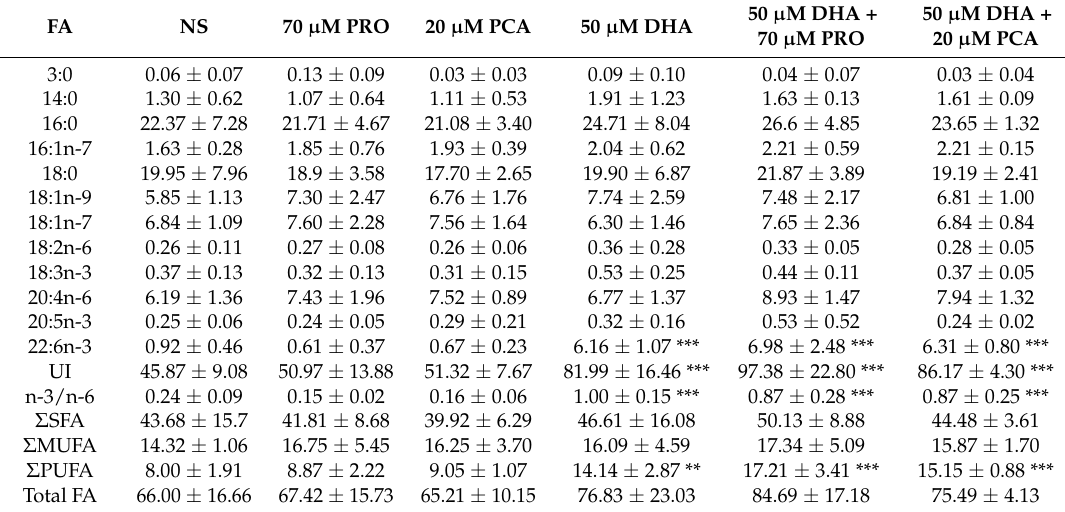
Table 2. Fatty acid content of not supplemented (NS) and supplemented cells after 6 h supplementation. Data were obtained by gas chromatography (GC) analysis, and are expressed as µ g FA/10 6 cells. Data in each group are means ± standard deviation (SD) of five samples derived from three independent experiments. Statistical analysis was conducted with the one-way ANOVA (22:6n-3 p < 0.001; UI p < 0.001; n-3/n-6 p < 0.001; Σ PUFA p < 0.001) using Dunnett’s post-test to compare NS and supplemented cells (** p < 0.01; *** p <